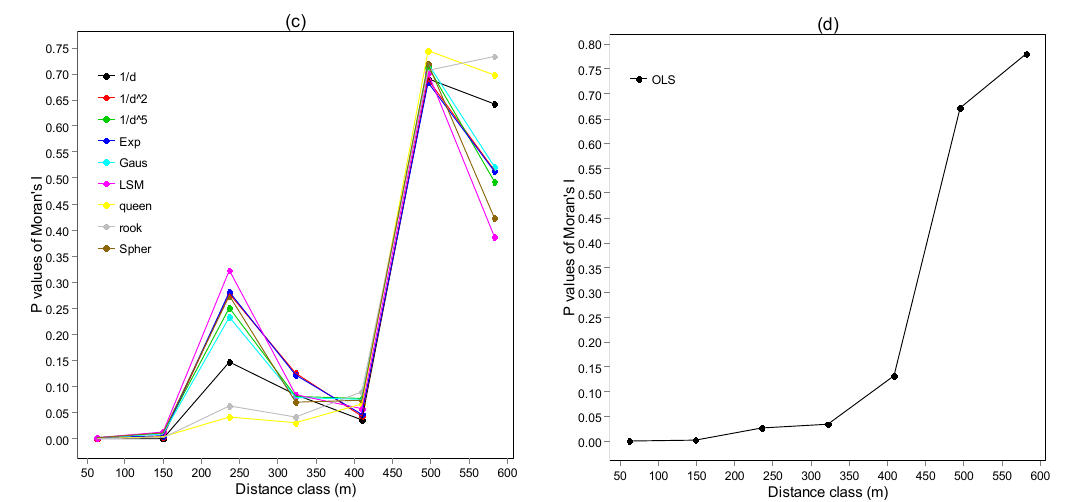
Figure 4. Diagram of p ‐ values of Moran’s I and distance class using three SAR models with nine spatial